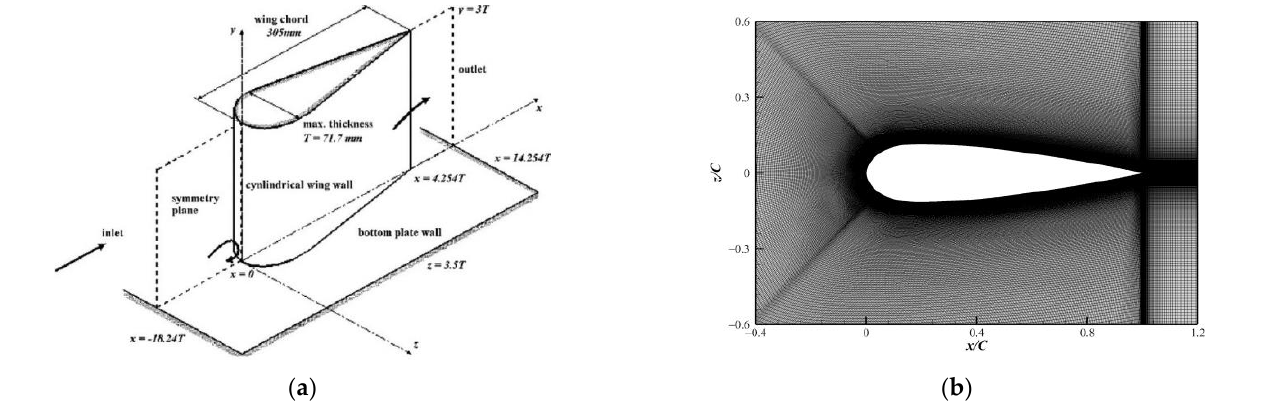
Figure 1. ( a ) Computational domain according to Ryu et al. [27]. ( b ) Near-wall region with fine grid. Table 1. Grid